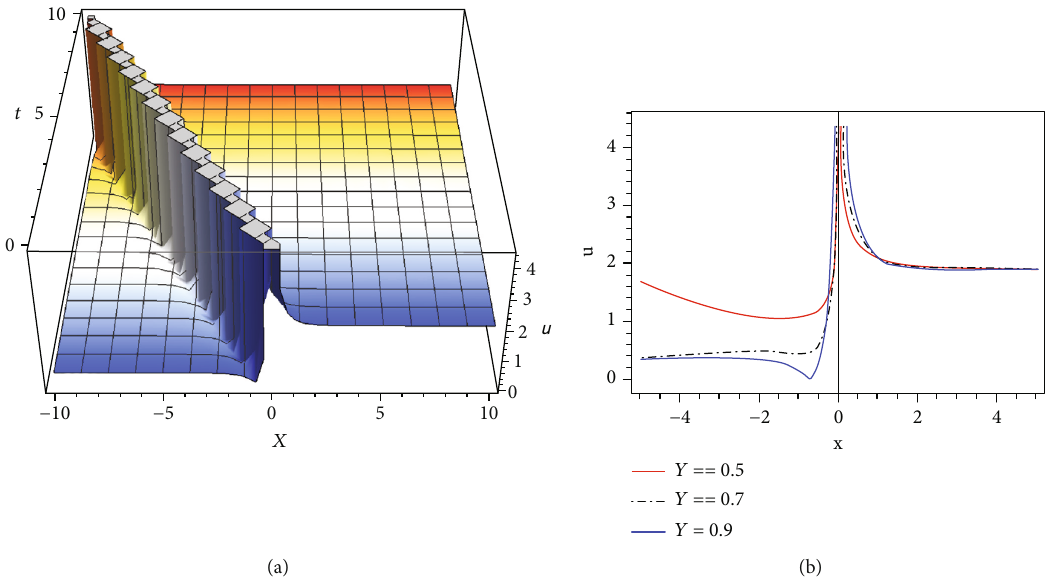
= 1 , T = 2 , V = 1 , c = 3 , a = 1 , b = 1 , and γ = 0 : 5,0 : 7,0 : 9 for the solution j u 1